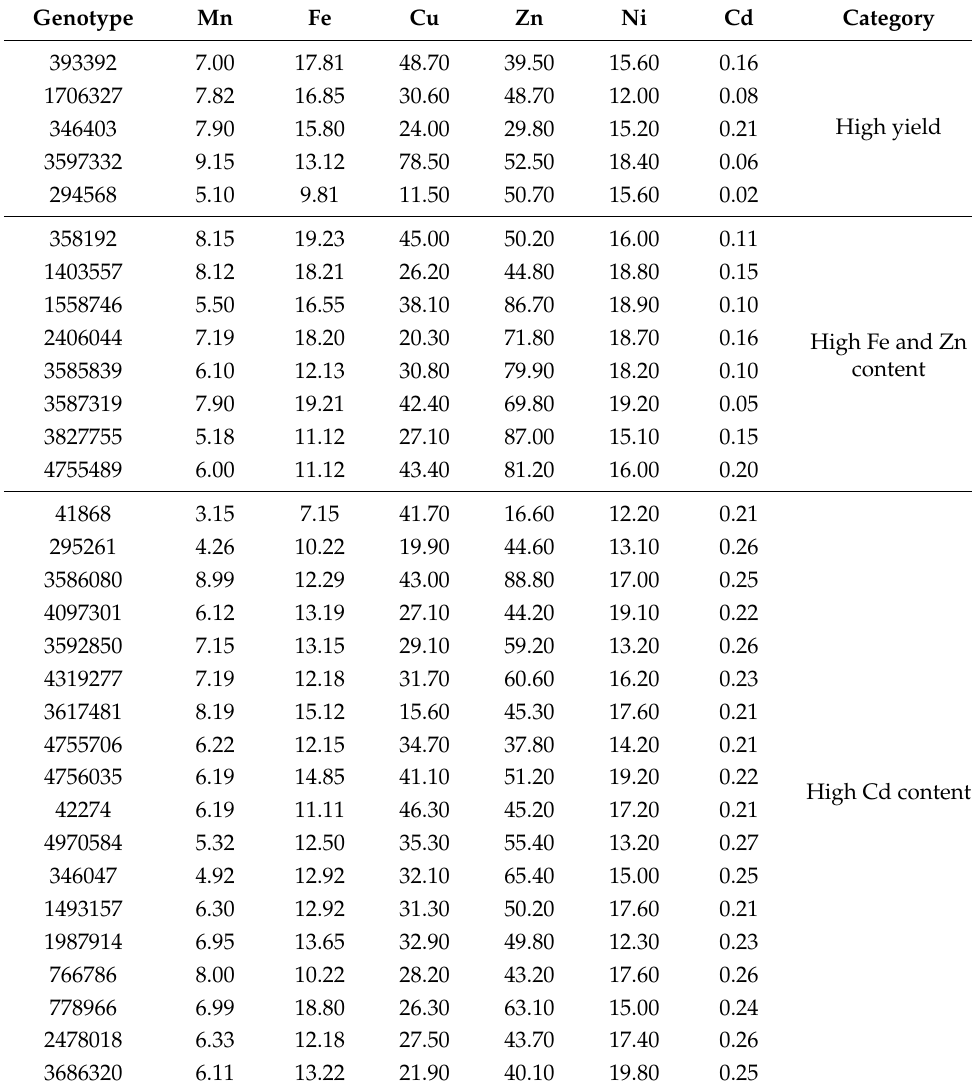
Table 2. Metals content (mg kg − 1 ) for genotypes with the highest yield, the highest Fe and Zn content, and the highest Cd